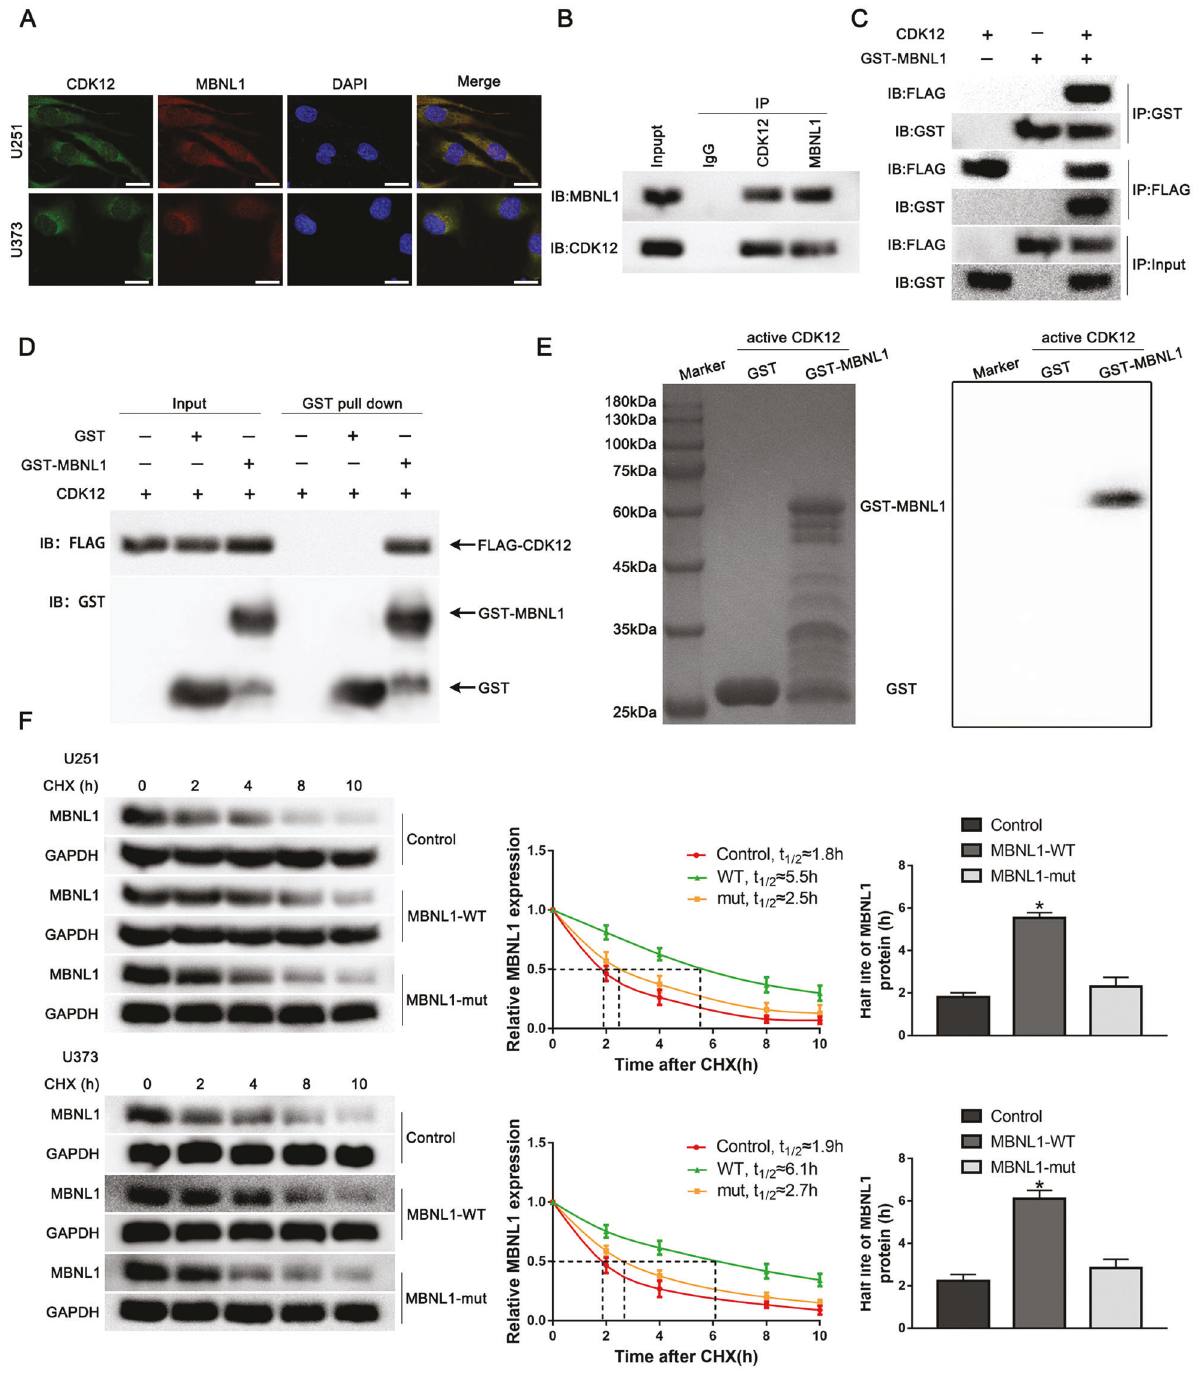
Fig. 5 CDK12 phosphorylated MBNL1. A The colocalization of CDK12 and MBNL1 in U251 and U373 cells by immuno fl uorescence assay. Green, CDK12; red, MBNL1; blue, DAPI nuclear staining. Scale bar: 10 μ m. B Lysates of U251 cells were subjected to immunoprecipitation (IP) and immunoblotting (IB) with CDK12 and MBNL1 antibodies. C Lysates of 293T cells transfected with FLAG-CDK12 and GST-MBNL1 plasmids were subjected to IP and IB with FLAG tag and GST tag antibodies. D The direct interaction between CDK12 and MBNL1 was con fi rmed by GST pull-down assay. GST protein functioned as a negative control. E Autoradiography detected phosphorylation of GST-MBNL1 fusion protein. F The effects of MBNL1 T6 phosphorylation site on its stability were detected by Cycloheximide (CHX) chase assay. Data are presented as the mean ± SD ( n = 3, each group). * P < 0.05, ** P < 0.01, compared with MBNL1-WT group by one-way CDK12 regulated transcription by binding to cycling K and Based on mRNA microarray analysis, we veri fi ed that CDK12 was phosphorylated RNA polymerase II Ser5 in vitro to regulate signi fi cantly decreased in U251 and U373 cells after BUD13 transcription initiation and was involved in DNA damage knockdown. The study proved that CDK12 was upregulated in response, cell proliferation, and pre-RNA splicing. In diffuse large GBM tissues and cells, and knockdown of CDK12 might inhibit the B-cell lymphoma, CDK12 activated MYC to inhibit miR-28-5p/EZH2 proliferation, migration, invasion, and tube formation of GBM cells.